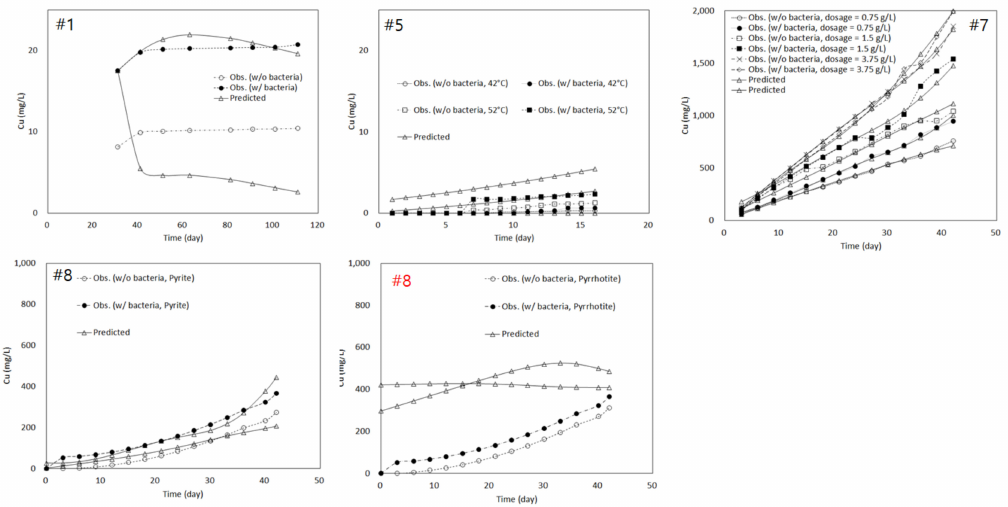
Figure5. ObservedandANN-predictedCuconcentrationchangeswithatopologyof9:8:1. Thenumbers are from Table 1, while the red number is the result from the data for further